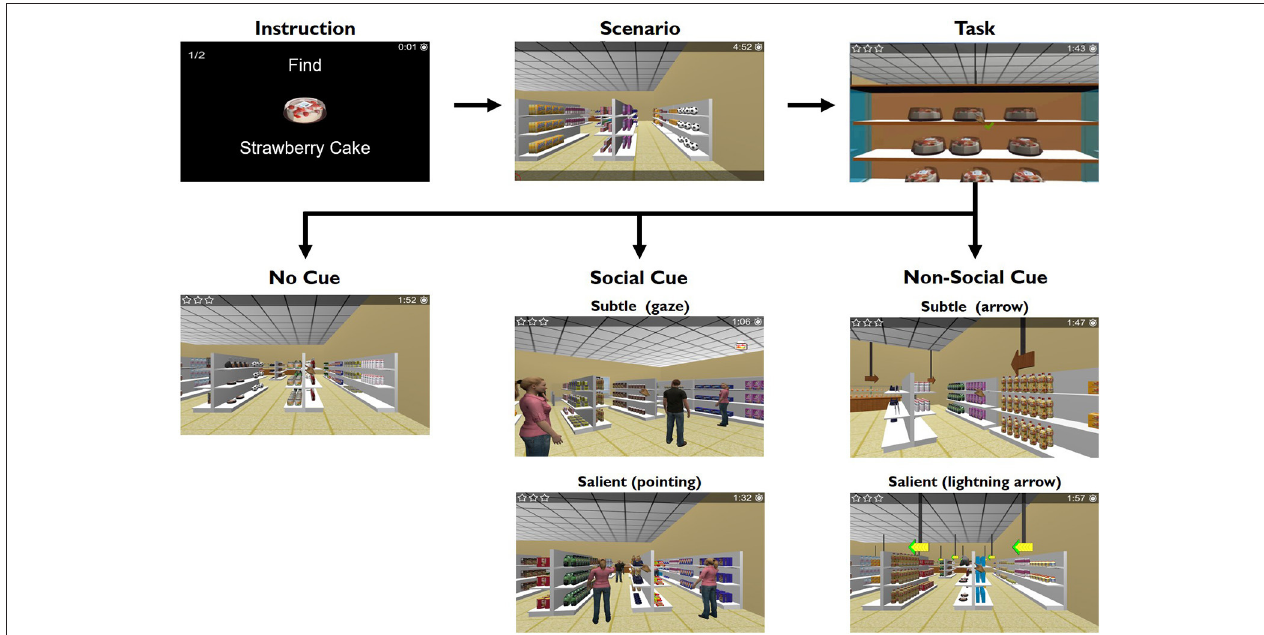
FIGURE 1 | EcoSupermarketX task design, considering the different types of cues. The test blocks included an instruction that consisted in the grocery list the participants had to pick. The grocery list (2, 3, or 4-items) was presented as an instruction individually in a trial-by-trial basis: “Find strawberry cake” followed by “Find sausages” in a 2-item grocery list, for example (each item image and name appeared for 3s). The grocery list had a variable number of items (two, three, or four) which defined the three different condition blocks with increased executive load. The groceries were replaced randomly in the shelves on a trial-by-trial basis. Participants were instructed to collect all items in the sequence they appeared in the list, and as fast and accurately as possible. Additionally, there were five different conditions in each 2, 3, or 4-item conditions: non-social salient (blinking luminous arrow), non-social subtle (wooden arrow), social salient (avatar pointing to the grocery), social subtle (avatar gazing to the grocery), and no